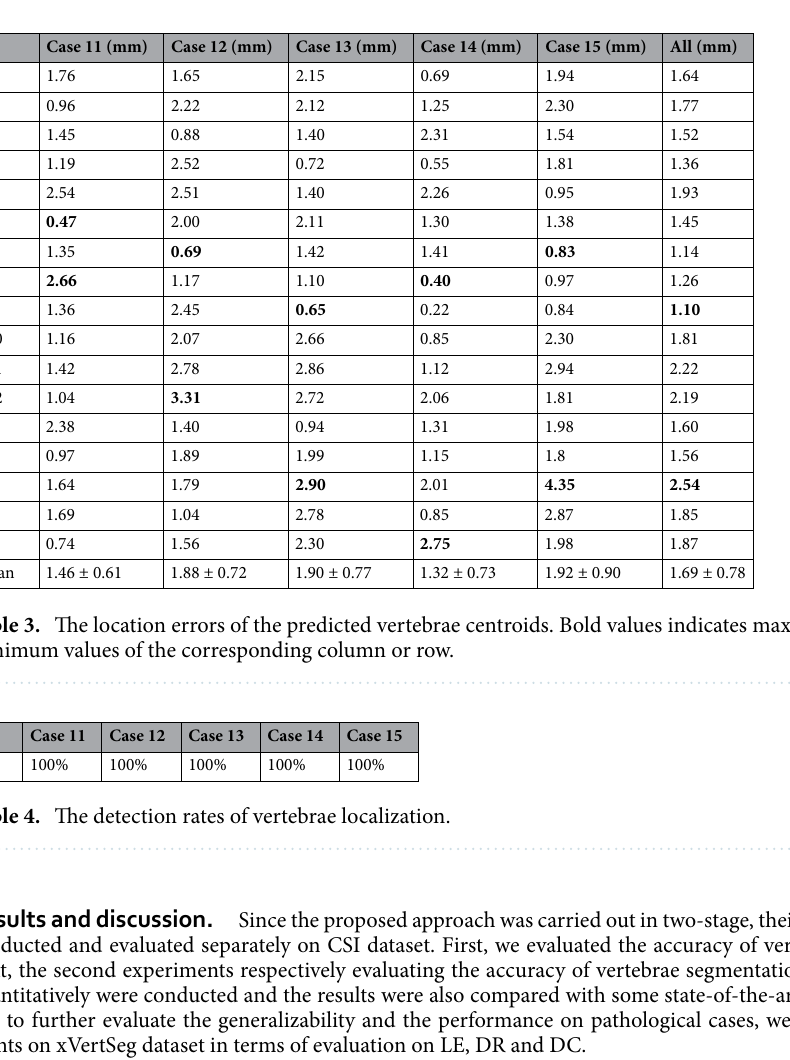
Figure 7. Visual demonstration of different LE and DR (the purple box is the identified ROI according to the predicted vertebra centroid ̂ c ). ( a ) DR: 100%. ( b ) DR: 95%. ( c ) ROI identified by the predicted vertebra centroid of case15/L3.